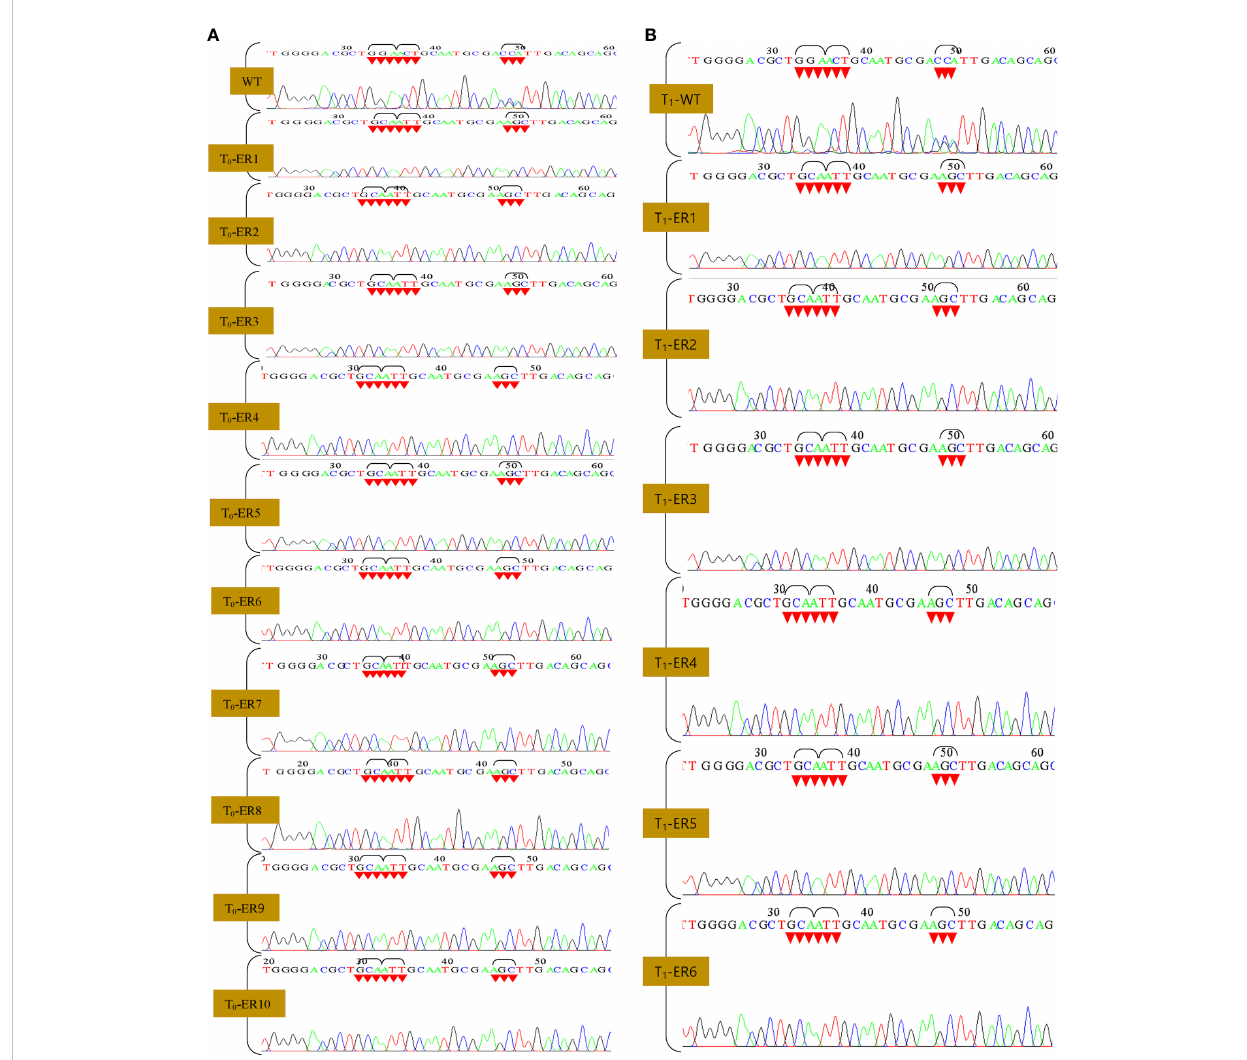
FIGURE 3 Sanger sequencing of edited rice lines (T 0 and T 1 generation). (A, B) Sequence chromatogram showing WT and modi fi ed EPSPS gene [glycine (GGA) to alanine (GCA), threonine (ACT) to isoleucine (ATT), and proline (CCA) to serine